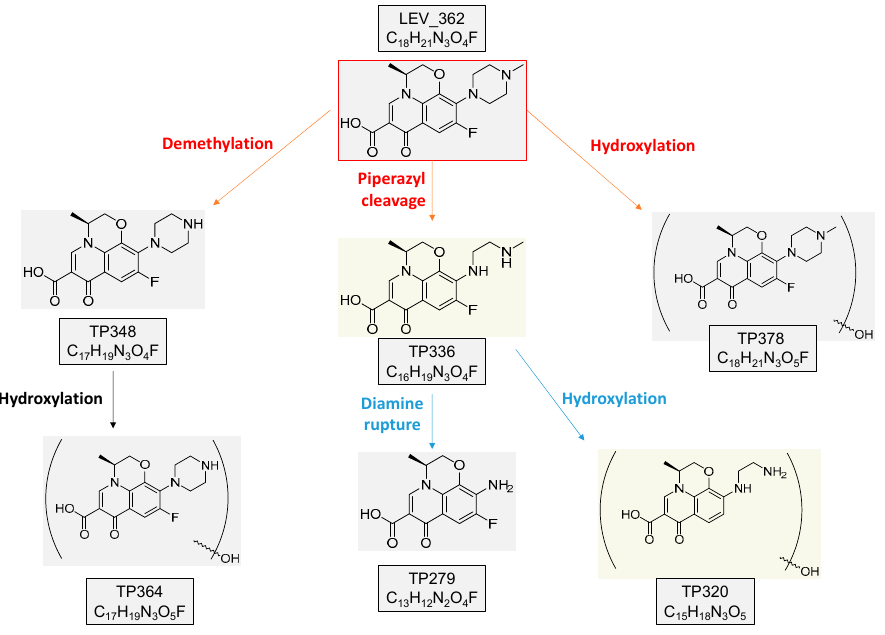
Figure 4. Schema of the primary transformations of LEV under photocatalysis using CdS.